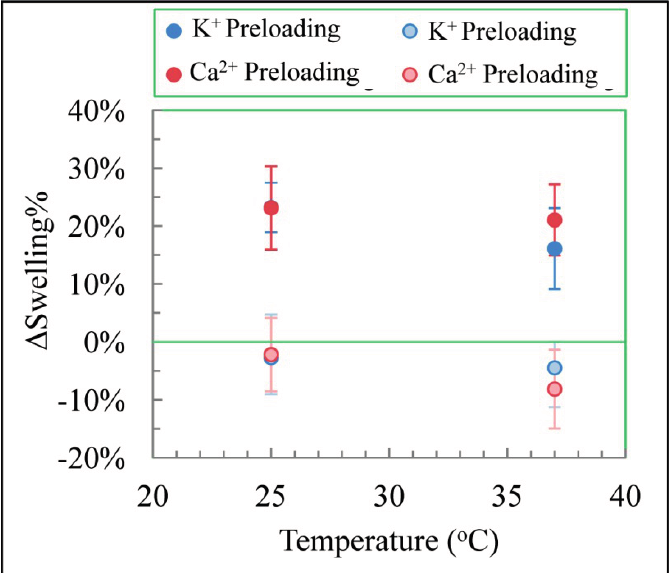
Figure 6. K + and Ca 2+ releasing hydrogels’ Δ Swelling% for pre- and post-loaded